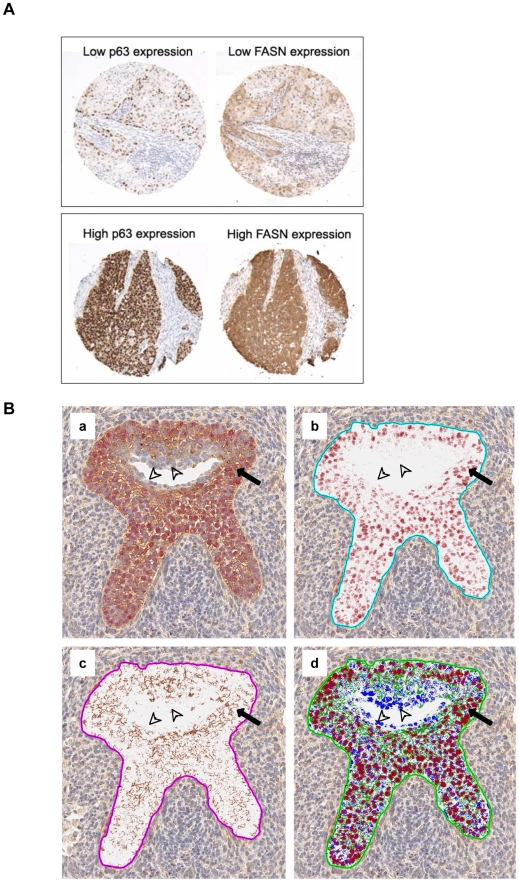
Co-localization of p63 and FASN in vivo.A. Immunohistochemical staining for FASN and p63 in TMAs containing cores from HNSCC tissues. Two representative cases are shown: one case displays both low p63 and low FASN expression (upper panel) and one case displays both high p63 and high FASN expression (lower panel). B. Co-localization of p63 and FASN in the UGS epithelium and prostatic buds. (a) A coronal section of the UGS from a wild-type E18.5 embryo was double immunostained for p63 (Fast Red) and FASN (DAB) and counterstained with hematoxylin. Deconvolved images of the DAB (b) and Fast Red (c) color channels as well a pseudo-colorized image (c) are also shown. In the pseudo-colorized image, the DAB channel (FASN) is displayed in green, the Fast Red channel (p63) is displayed in red and the hematoxylin channel is displayed in blue. Expression of both FASN and p63 proteins is observed in the vast majority of the cells. The cells lining the UGS lumen are consistently negative for both FASN and p63.